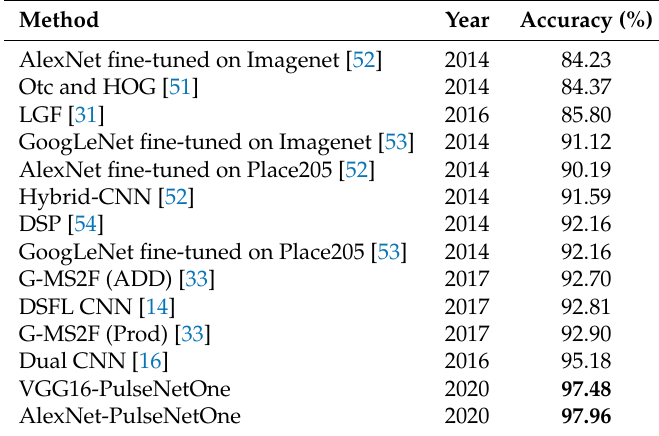
Table 9. A comparison between state-of-the-art and PulseNetOne results on the SCENE15 data set. The entries in bold show the method with the best classification for the network.